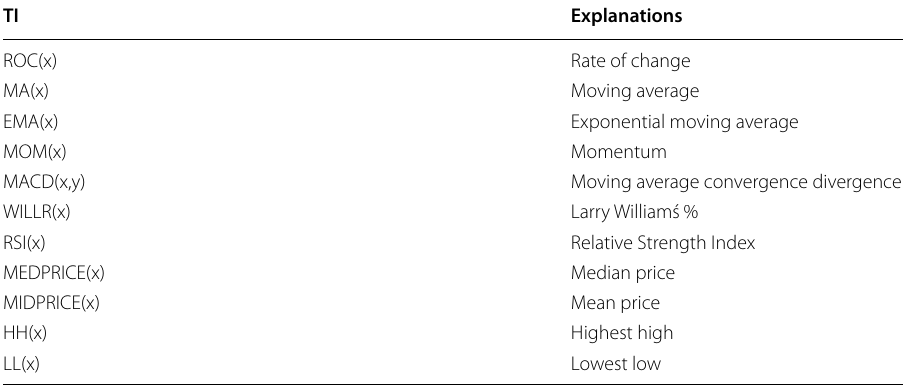
Table 1 Used technical indicators (TI) (x and y denote hourly time periods)